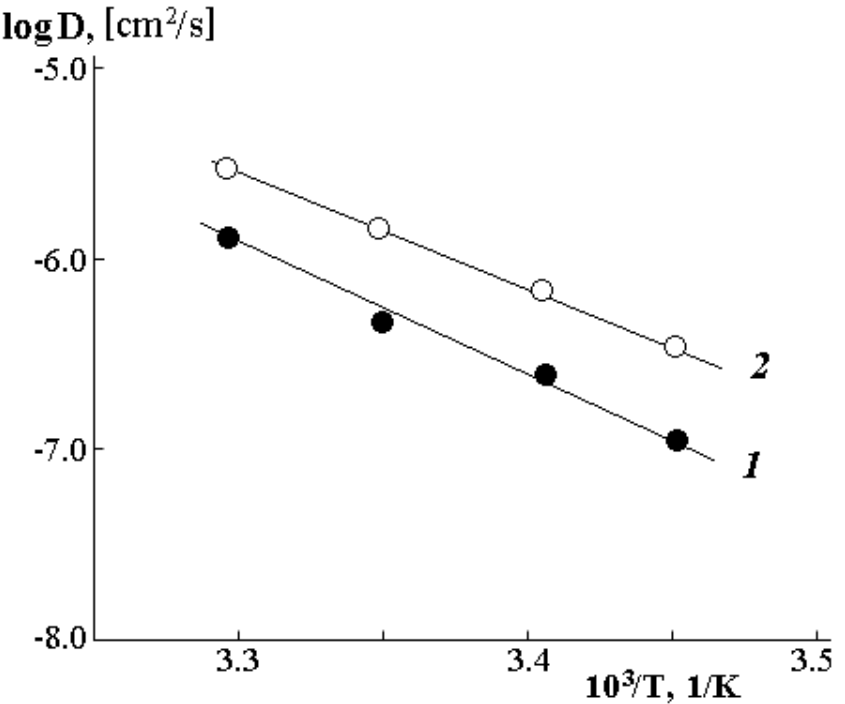
Figure 10. Temperature dependence of the interdiffusion coefficients into the PVME matrix (1) and into the water matrix (2).